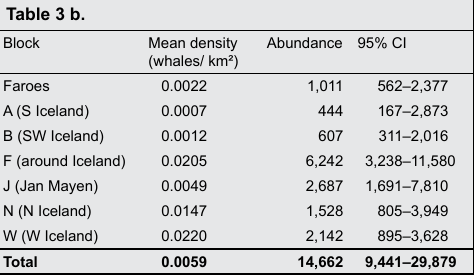
Table 3a and 3b. Estimates of mean density (whales/ km²), abundance and 95% confidence intervals bootstrap (top) by block for a) 1995 and b)